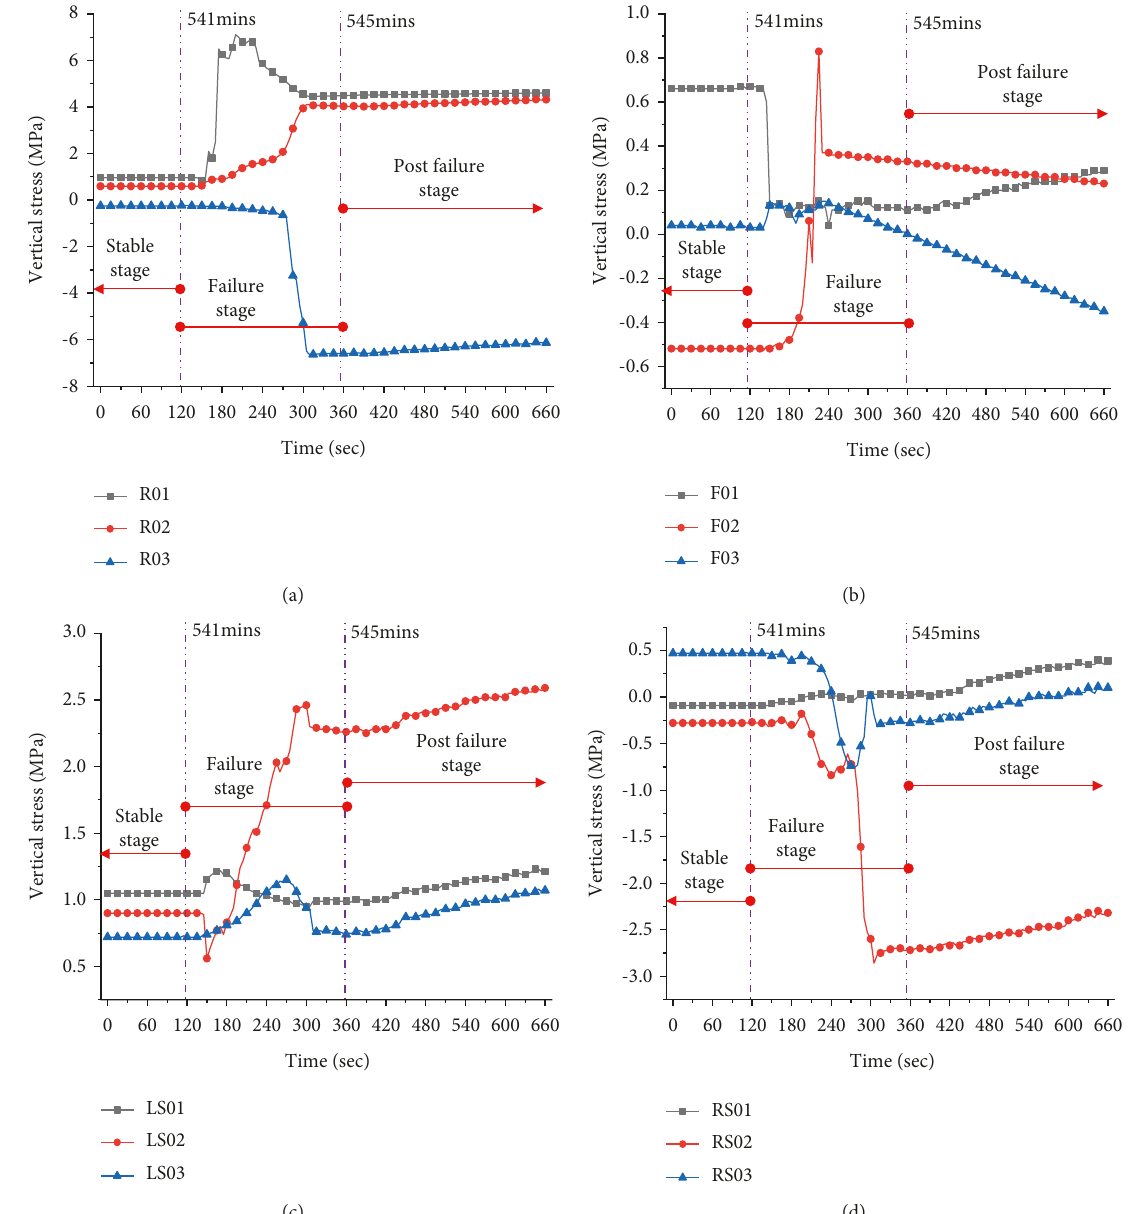
Figure 15: Vertical stress of measuring points when the cumulative duration is 539–550 mins; (a) R01, R02, and R03; (b) F01, F02, and F03; (c) LS01, LS02, and LS03; and (d) RS01, RS02, and